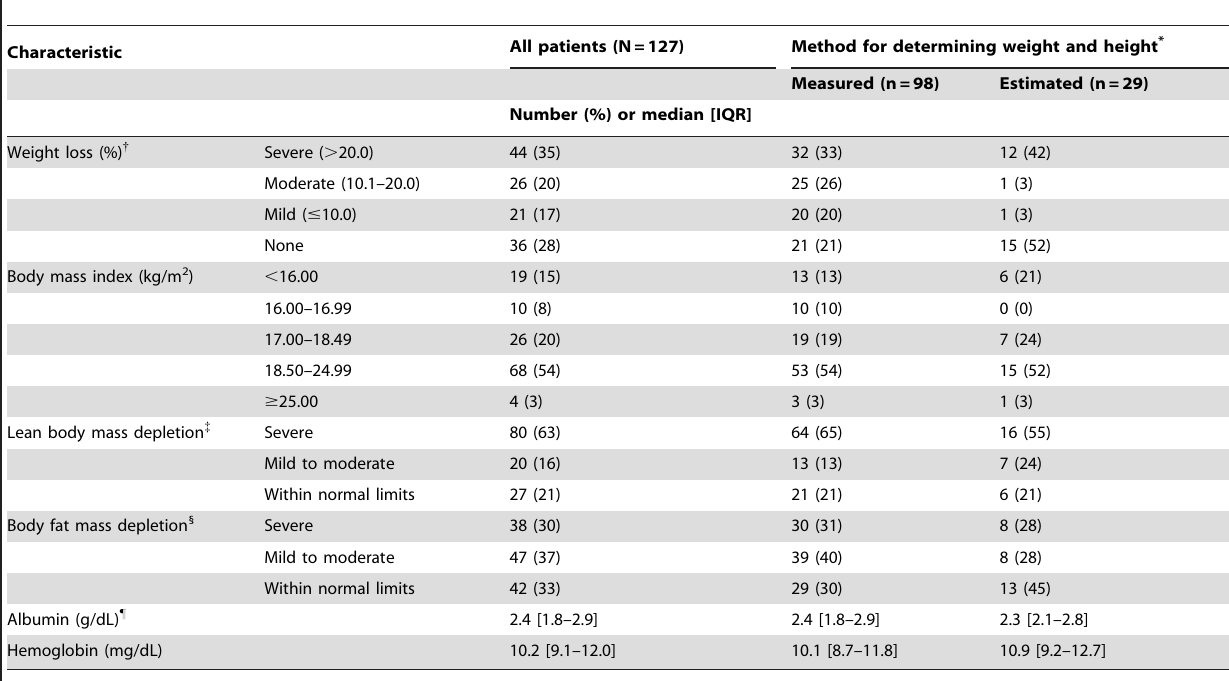
Table 2. Nutritional characteristics of patients hospitalized with AIDS according to the method used to determine weight and